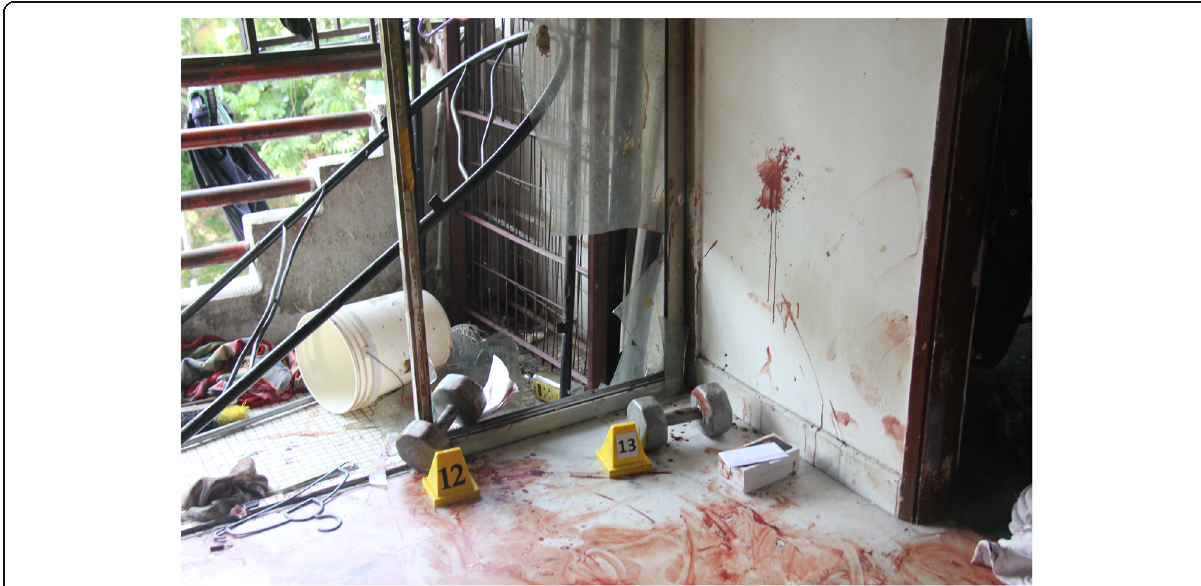
Fig. 2 Heavy dumbbells were used to break the sliding glass door and other mirrors in the unit. Broken glass pieces were scattered on the floor, where the body was